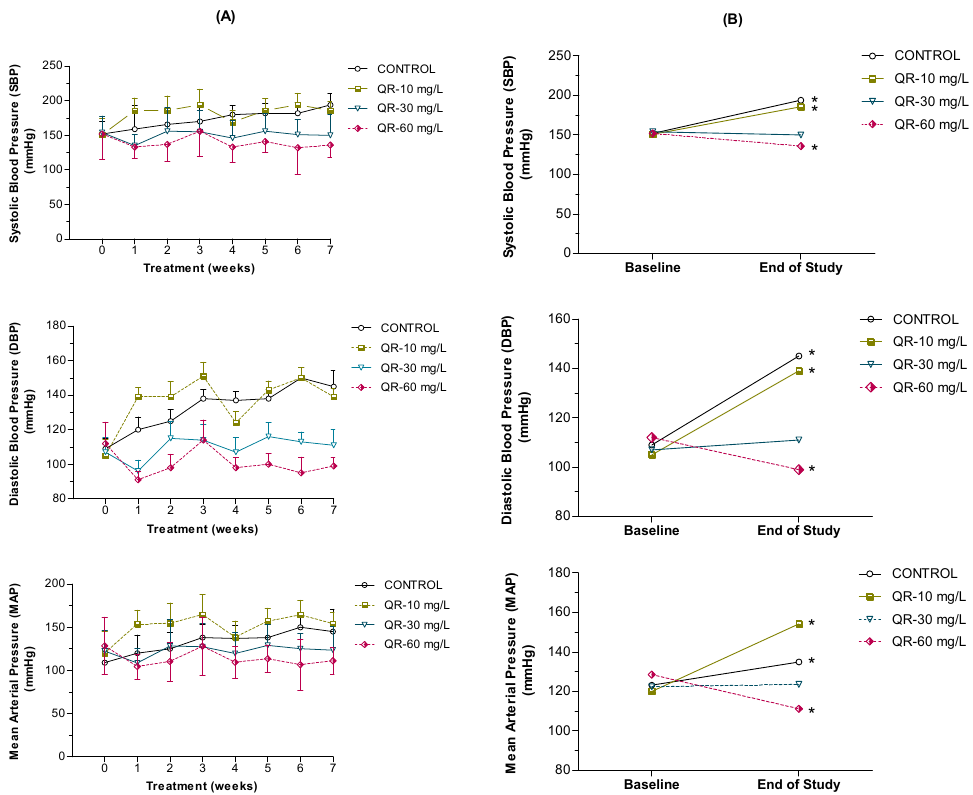
Figure 3. Average weekly systolic, diastolic, and mean arterial blood pressure of control and QR-treated male spontaneously hypertensive rats (SHR) ( A ). Changes in blood pressure in both control and QR-treated SHR rats during the 7-week study period ( B ). Data are presented as mean ± SEM ( n = 8). * indicates significant difference, lower or higher, from baseline.